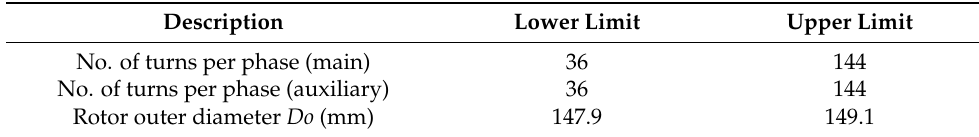
Table 4. Design variables and their limits.